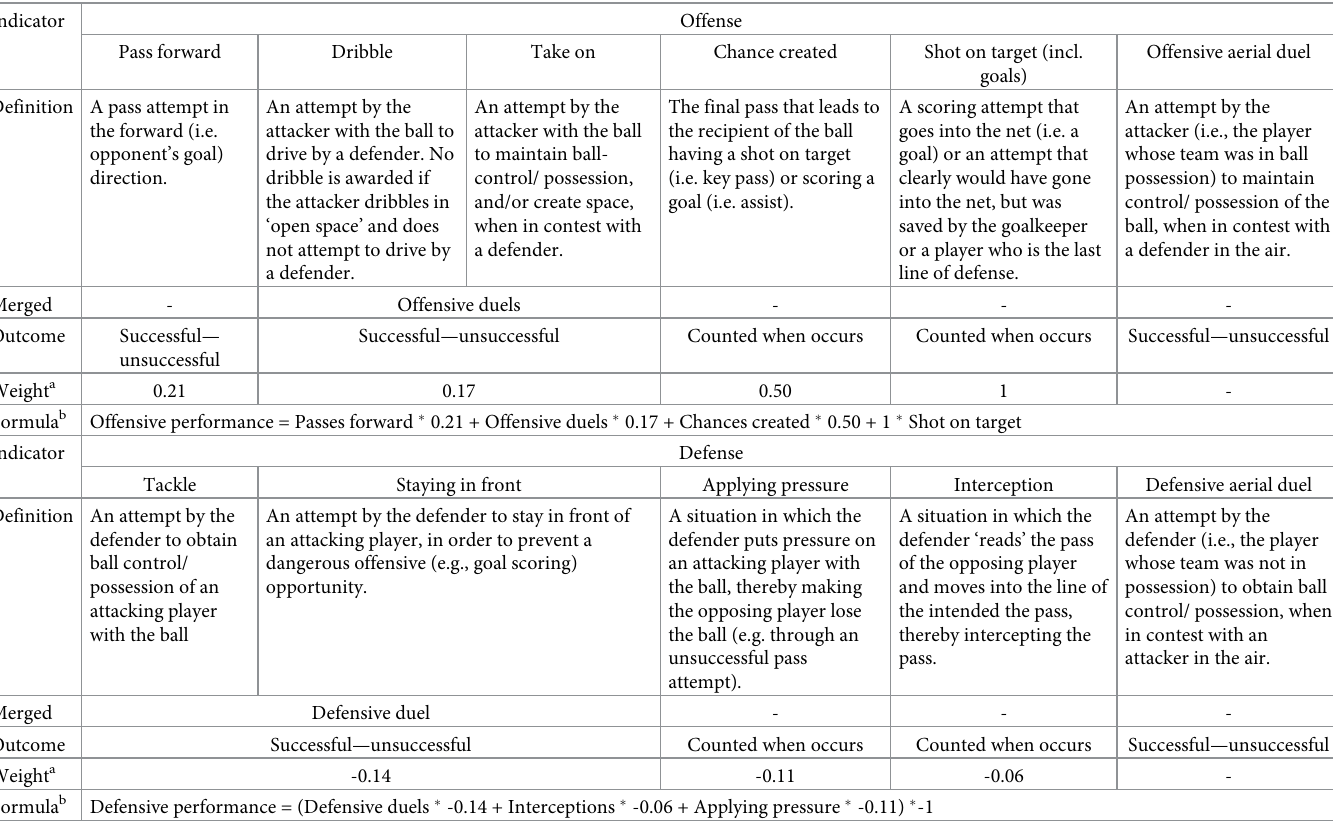
Table 2. Definitions and weights for offensive and defensive performance